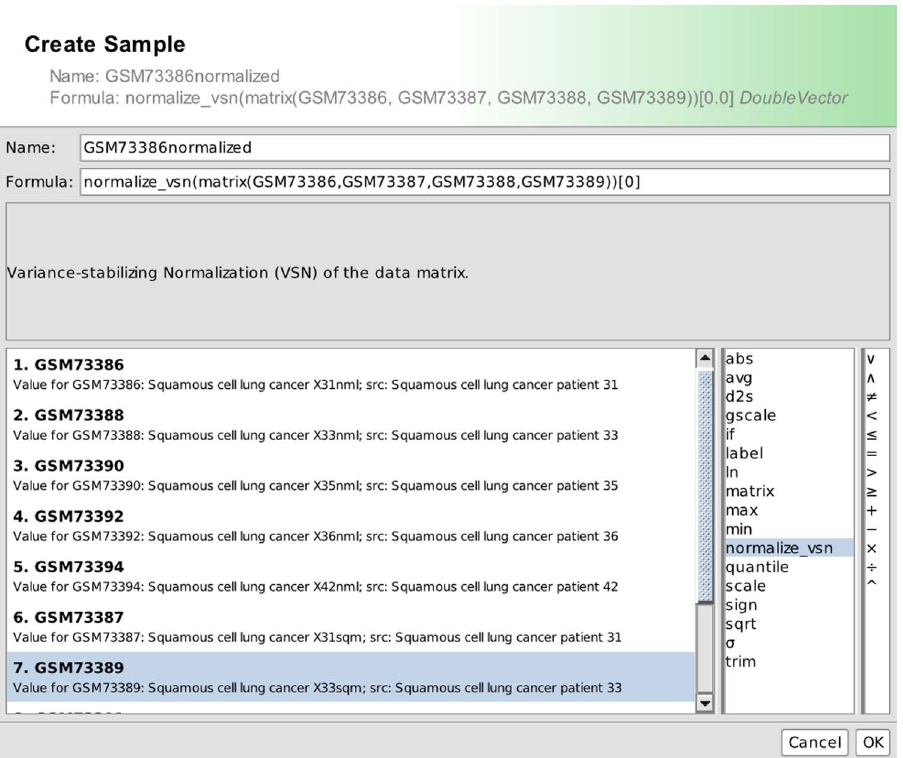
Figure 5. Derive new data sets using R. Creation of a new sample (dataset) using the callback function defined in Figure 4.